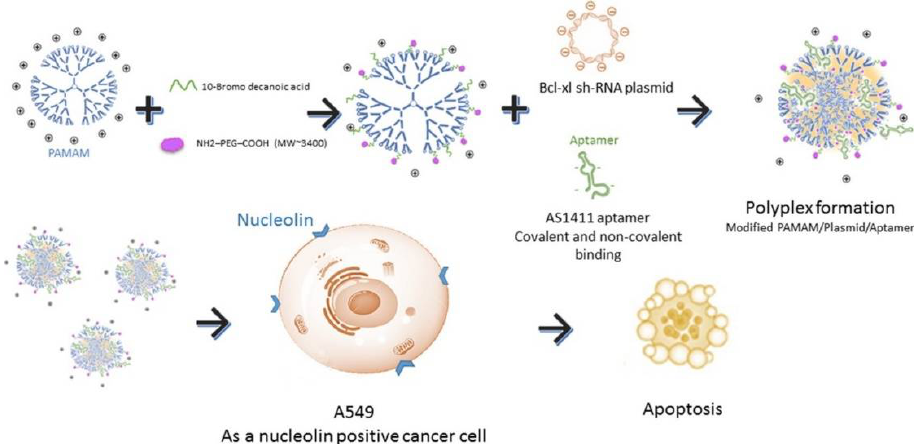
Figure 8. Schematic representation of AS1411-conjugated modified PAMAM dendrimers. These dendrimers efficiently target nucleolin positive cells (A549 cells), knockdown the protein expression of Bcl-xL and induce apoptosis in the target cells. Reprinted from The International Journal of Biochemistry and Cell Biology, 92, Ayatollahi, S.; Salmasi, Z.; Hashemi, M.; Askarian, S.; Oskuee, R.K.; Abnous, K.; Ramezani, M., Aptamer-targeted delivery of Bcl-xL shRNA using alkyl modified PAMAM dendrimers into lung cancer cells, 210–217, Copyright (2017), with permission from Elsevier [91].